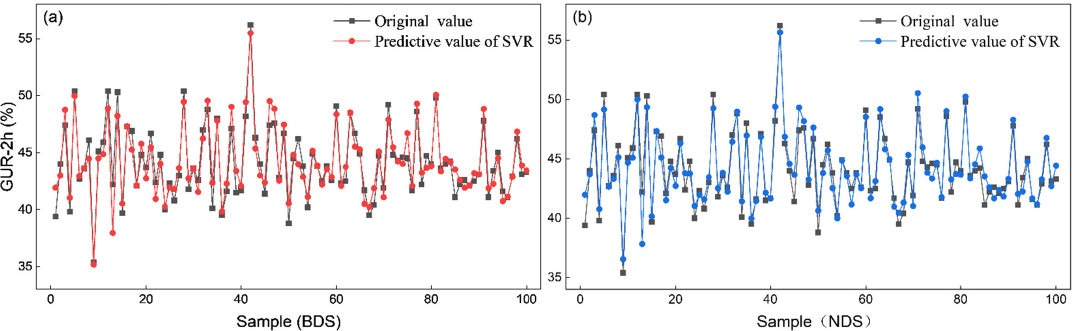
Figure 8. The prediction results of the SVR model using the BDS ( a ) and NDS ( b ) (the forecasting parameter is the GUR-2h). Figure 8a,b show the comparisons among the original values and the predicted val- ues of the SVR model based on BDS and NDS when the predicted parameter is the GUR- 2h, respectively. The predictive errors of the SVR model constructed using the BDS and the NDS are shown in Figure 9.